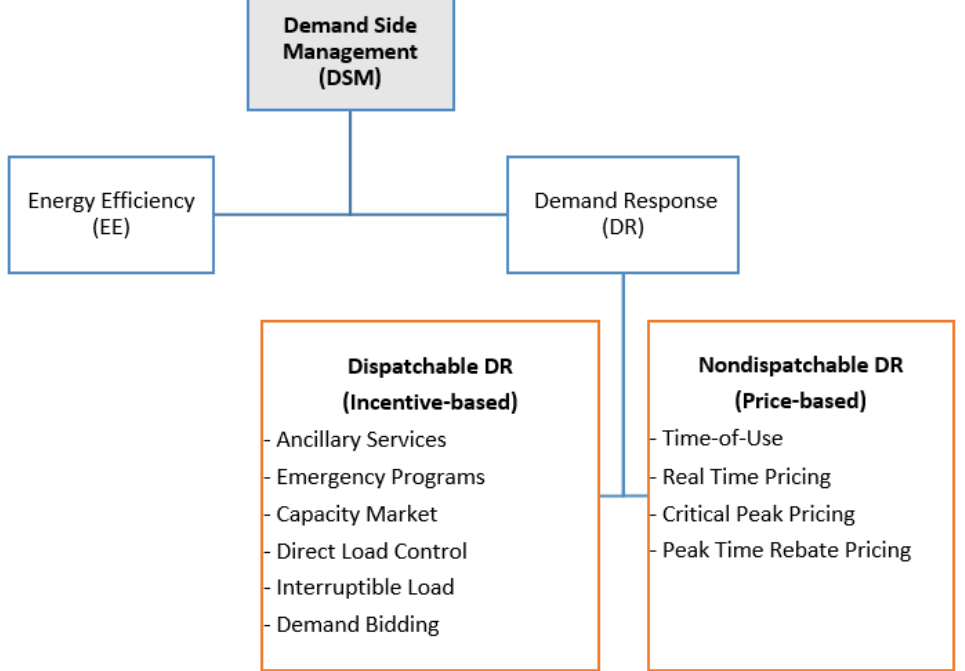
Figure 1. Classification of mainly DSM